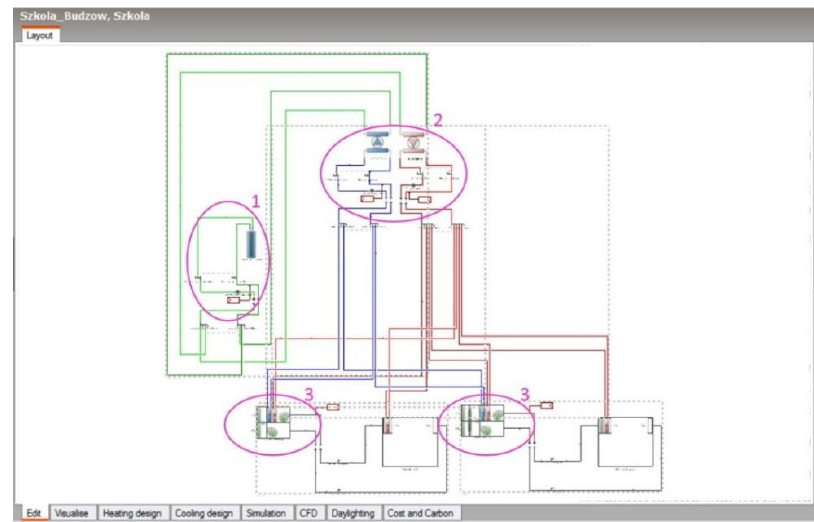
Figure 5. Diagram of the HVAC system modeled in Design Builder.